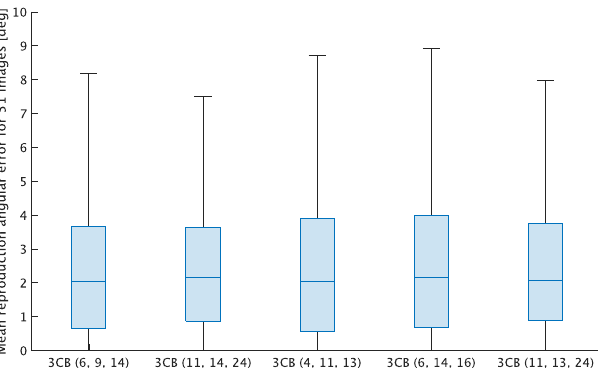
Figure 6. Box plot of three-color balancing with five combinations of target colors. Boxes span from the first to third quartile, referred to as Q 1 and Q 3 . Whiskers show maximum and minimum values in range of [ Q 1 − 1.5 ( Q 3 − Q 1 ) , Q 3 + 1.5 ( Q 3 − Q 1 )] . The band inside boxes indicates the